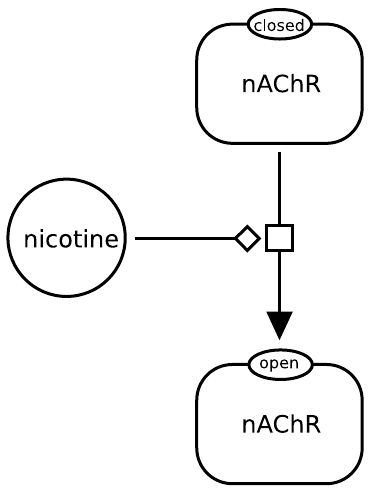
Figure 2.45: Modulation of nicotinic receptor opening by nicotine.